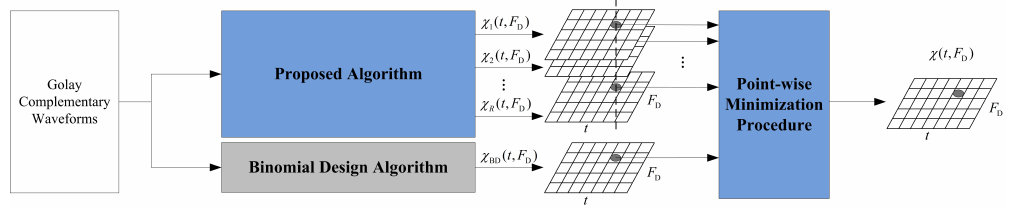
Figure 2. The schematic figure of the proposed signal processing